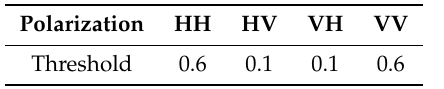
Table 1. The thresholds of different